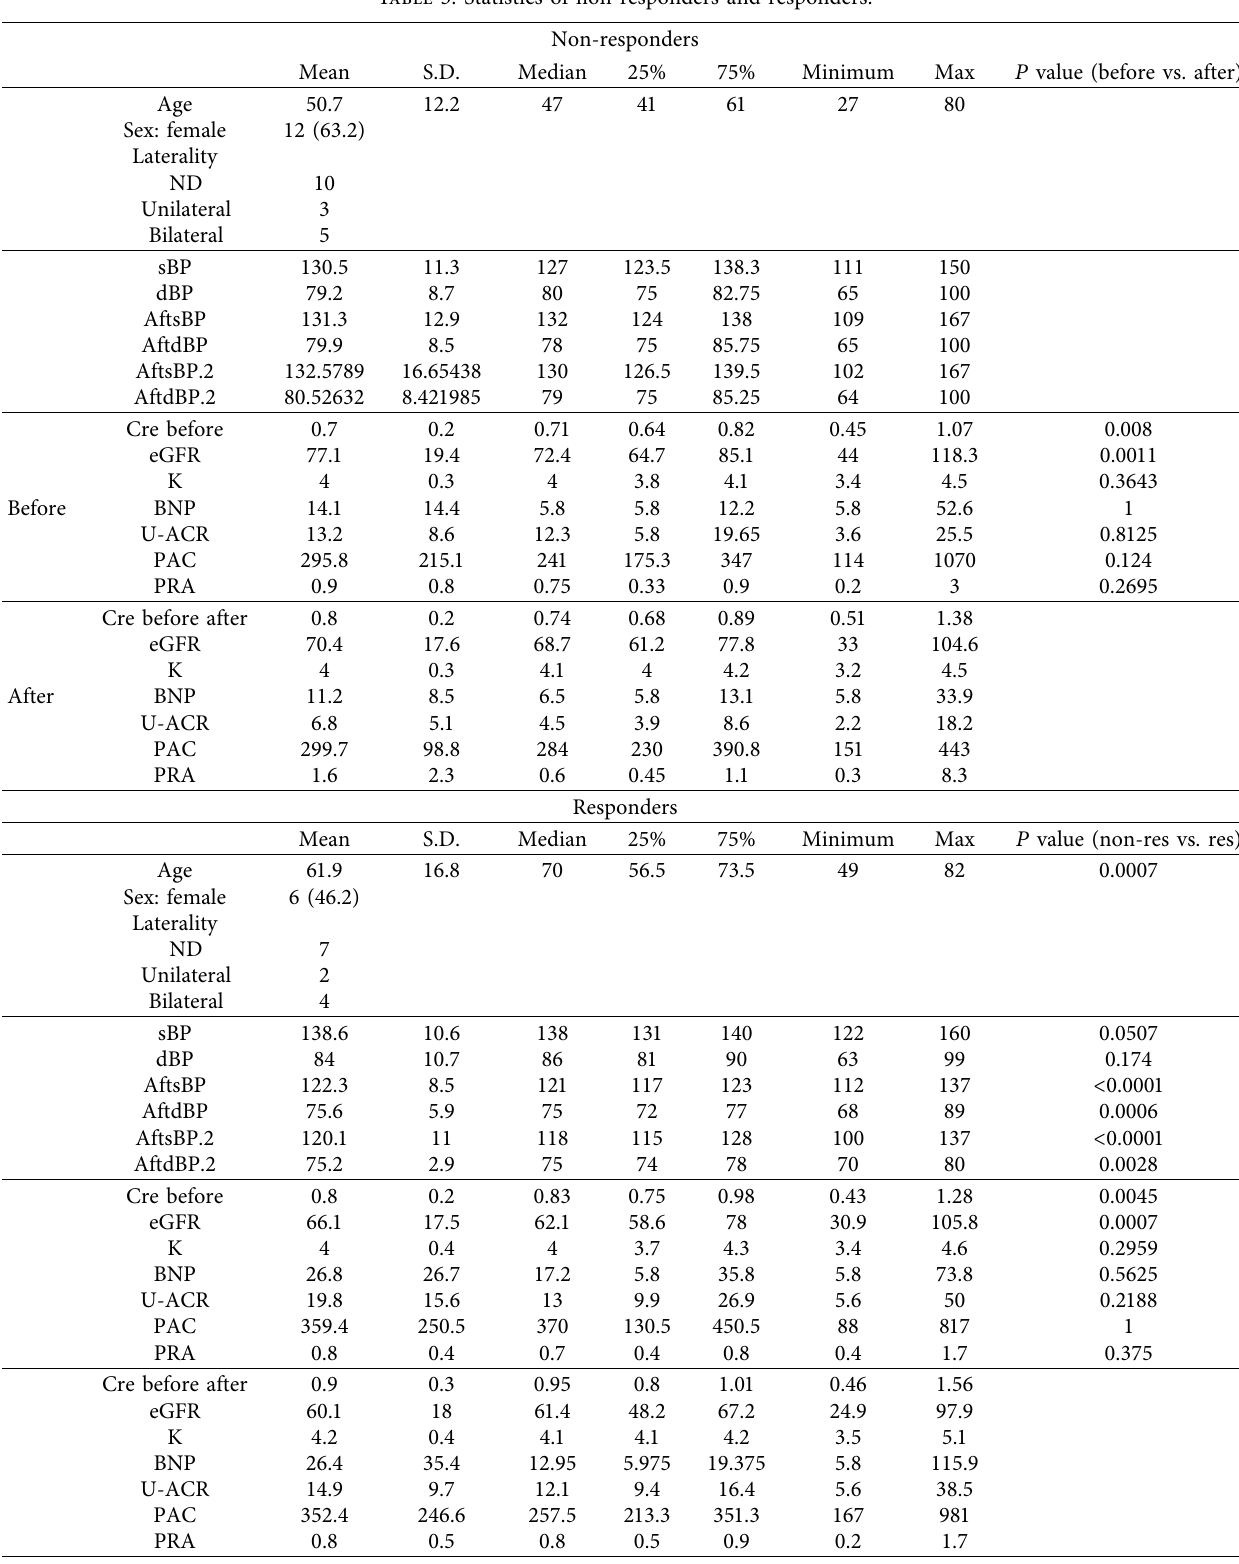
Table 3: Statistics of non-responders and